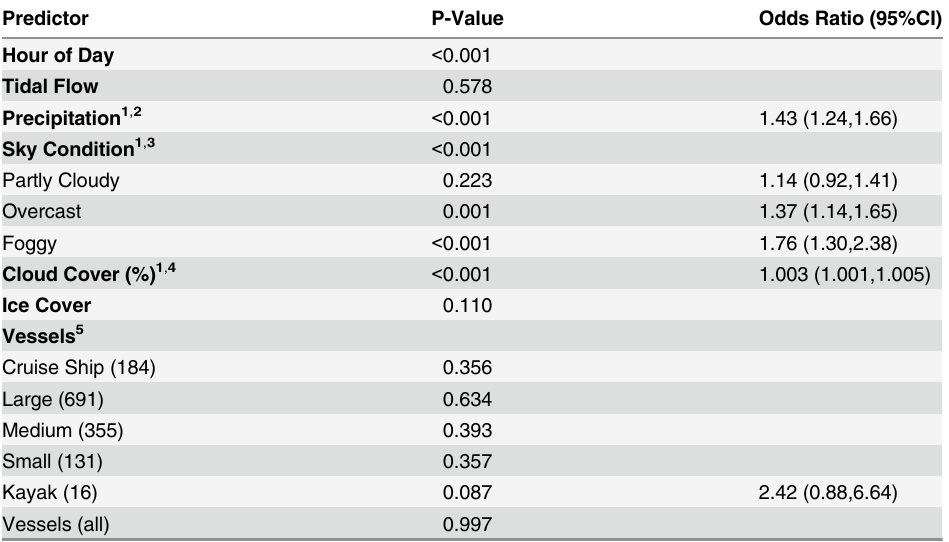
Table 6. Predictors related to the probability of an observation being a ‘ start-of-haulout ’ observation. Predictor